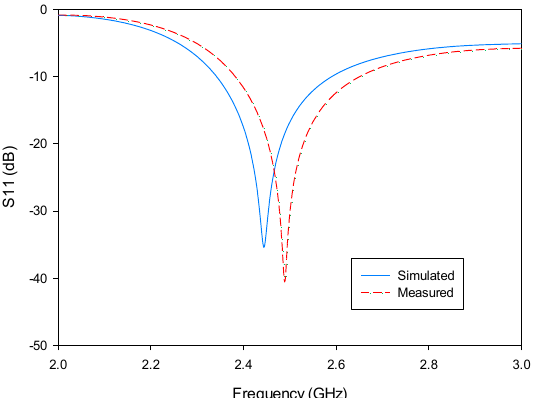
Figure 4: Simulated and measured variations of return loss with frequency of the proposed slot antenna loaded with rotated square SRR